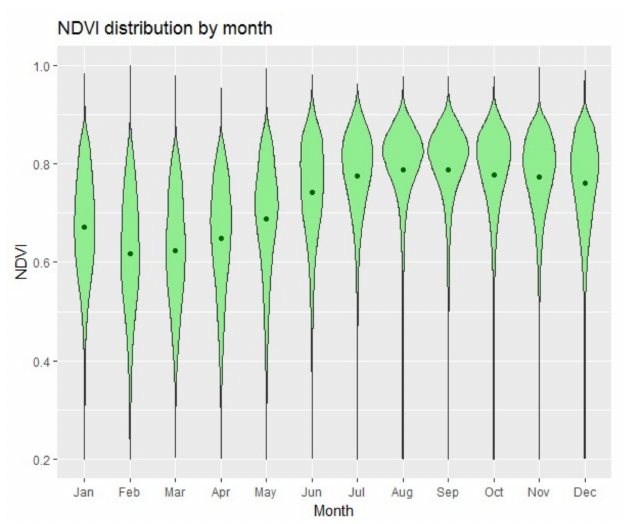
Figure A2. Violin plot of monthly average normalized difference vegetation index (NDVI) in northwest Vietnam in 2015.